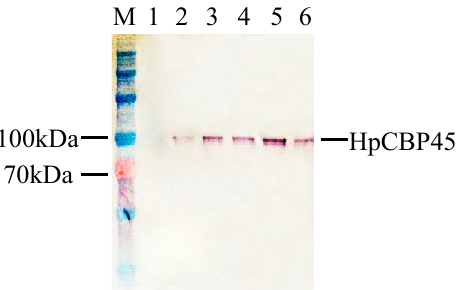
Figure 4. Western blot analysis of HpCBP45 expression in recombinant yeast.